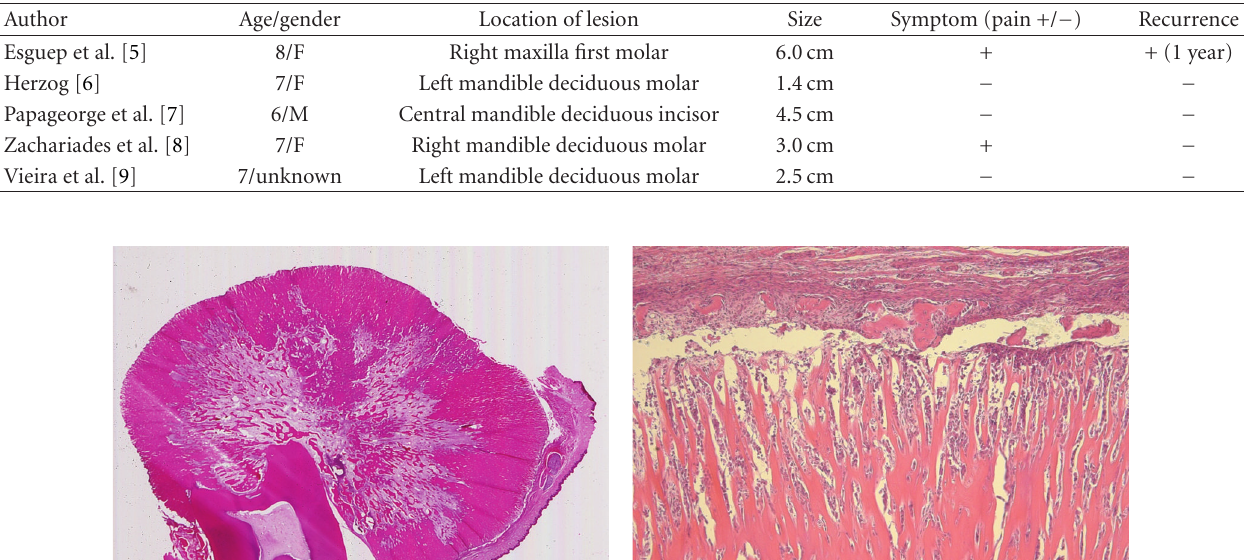
Table 1: Clinical data for five cementoblastoma patients under age 10.